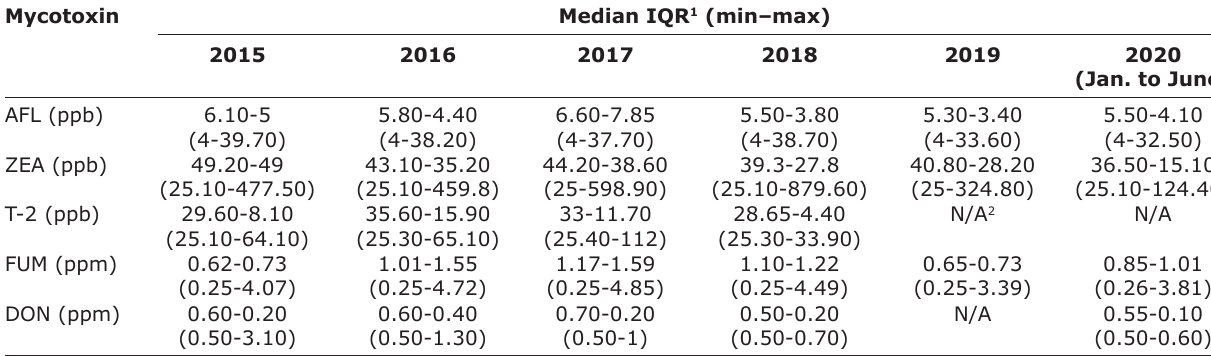
Table-2: Mycotoxin levels based on the samples in the detection ranges in the central part of Thailand from 2015 to 2020.